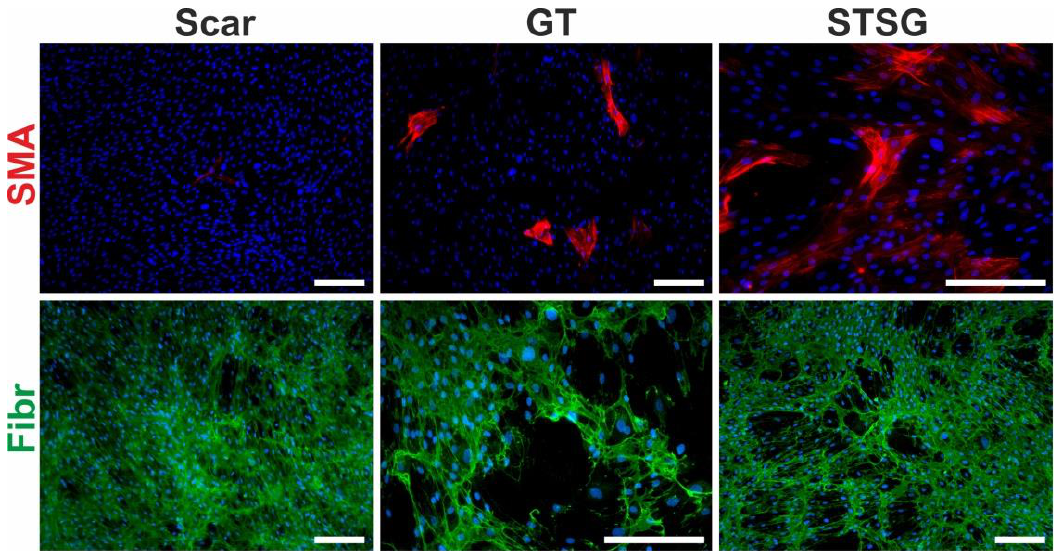
Figure 5. Primary cultures of human dermal fibroblasts isolated from matured scar (Scar), granulation tissue (GT) and split-thickness skin graft (STSG). Cultures were stained for α-smooth muscle actin (SMA, red signal), fibronectin (Fibr, green signal) and nucleus (DAPI, blue signal) (scale bar 100 µm).